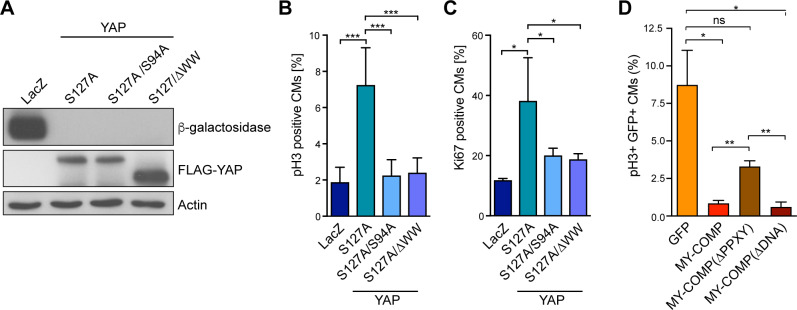
The YAP-B-MYB interaction is required for cardiomyocyte proliferation.A) Cardiomyocytes isolated from P1 hearts were transduced with Ade-LacZ, Ade-YAP[S127A], and Ade-YAP[S127A/S94A] or with Ade-YAP[S127A/ΔWW]. Expression of ß-galactosidase and of flag-tagged YAP constructs was verified by immunoblotting. Actin served as a loading control. B) and C) Cardiomyocytes were transduced with the constructs as described in A. The fraction of pH3-positive positive (B) and Ki67-positive (C) cardiomyocytes was determined. Example microphotographs are shown in S7A and S7B Fig. Error bars show SD. (B) n = 6–8, (C) n = 3–4 biological replicates. D) Disruption of the YAP-B-MYB interaction by MY-COMP inhibits mitosis of cardiomyocytes. Embryonal cardiomyocytes were infected with adenoviruses expressing GFP, MY-COMP, MY-COMP, ΔPPXY or with MYCOMP, ΔDNA each coupled to GFP through a T2A self-cleaving peptide. Infected cardiomyocytes were detected by staining for cTnT and by their green fluorescence. Mitotic cells were quantified by staining for phospho-H3. Example microphotographs are provided in S7C Fig. Error bars indicate SEMs. Student’s t-test. * = p<0.05, ** = p<0.01, *** = p<0.001, ns = not significant.